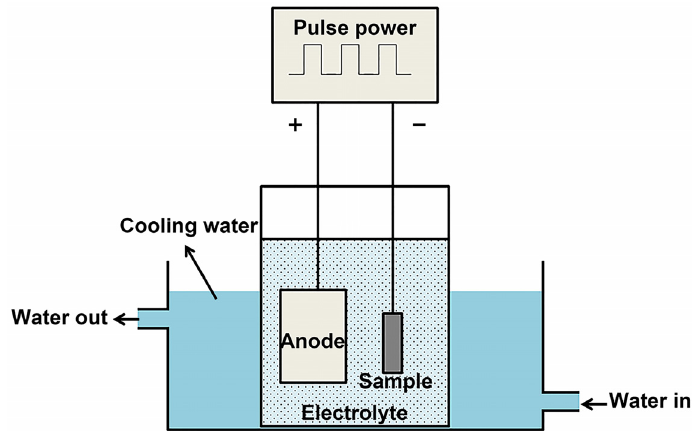
Figure 1. Schematic diagram of the CPED experimental device.